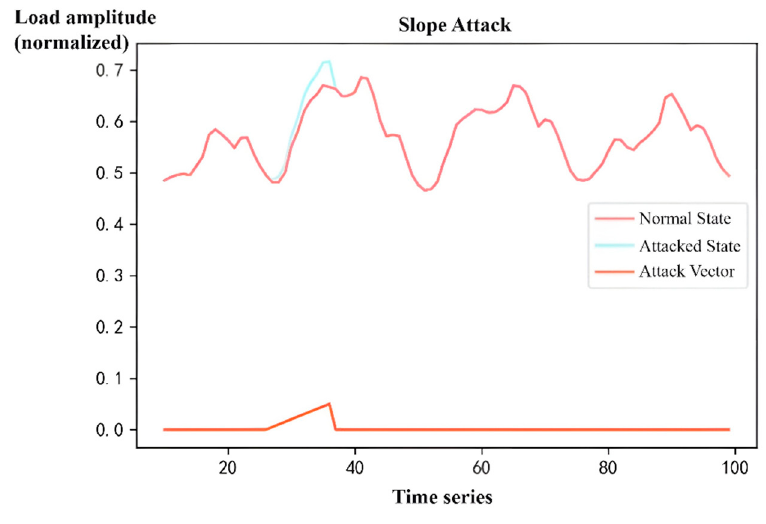
Figure 2. Slope attack.